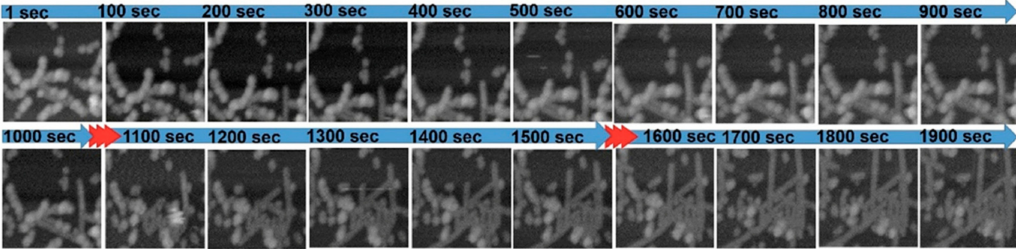
Figure 5. HS-AFM imaging of tip-induced A β 42 filament growth. The HS-AFM tapping amplitude was transiently increased at the time indicated by the red arrows. Reprint with permission [112]; Copyright (2019), John Wiley and